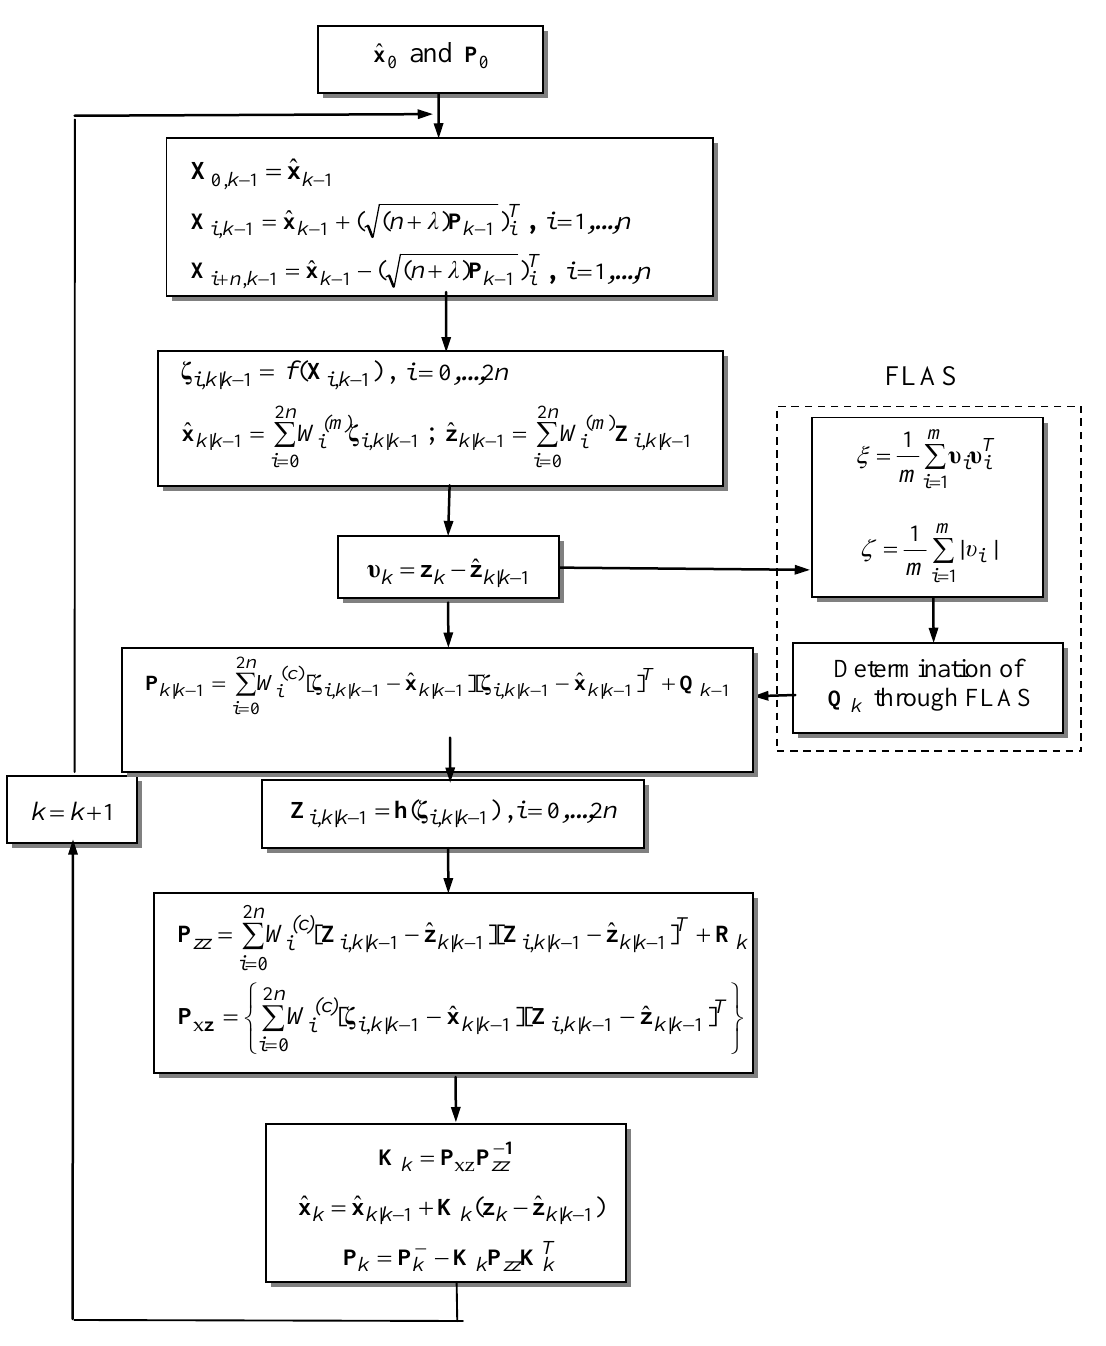
Figure 3. The flow chart of the